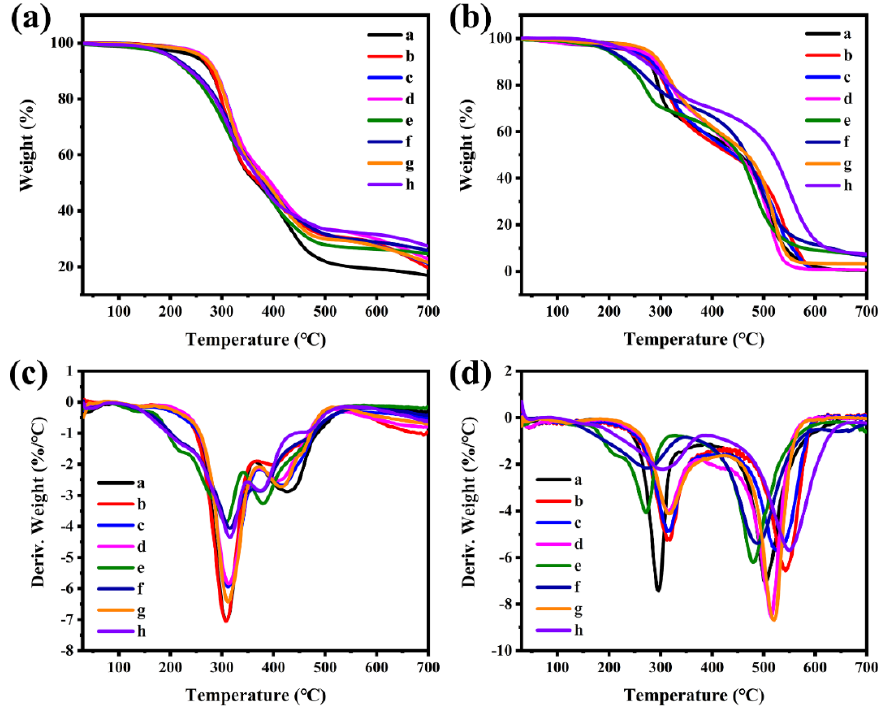
Figure 9. TGA curves of RPUFs under N 2 ( a ) and under air ( b ), DTG curves of RPUFs under N 2 ( c ) and under air ( d ). (a: neat RPUF; b: RPUF-MOF/MWCNTs 1; c: RPUF-MOF/MWCNTs 2; d: RPUF-MOF/MWCNTs 3; e: RPUF-T; f: RPUF-T/MOF/MWCNTs 2; g: RPUF-C-MOF/MWCNTs 2; h: RPUF-T/C-MOF/MWCNTs 2).